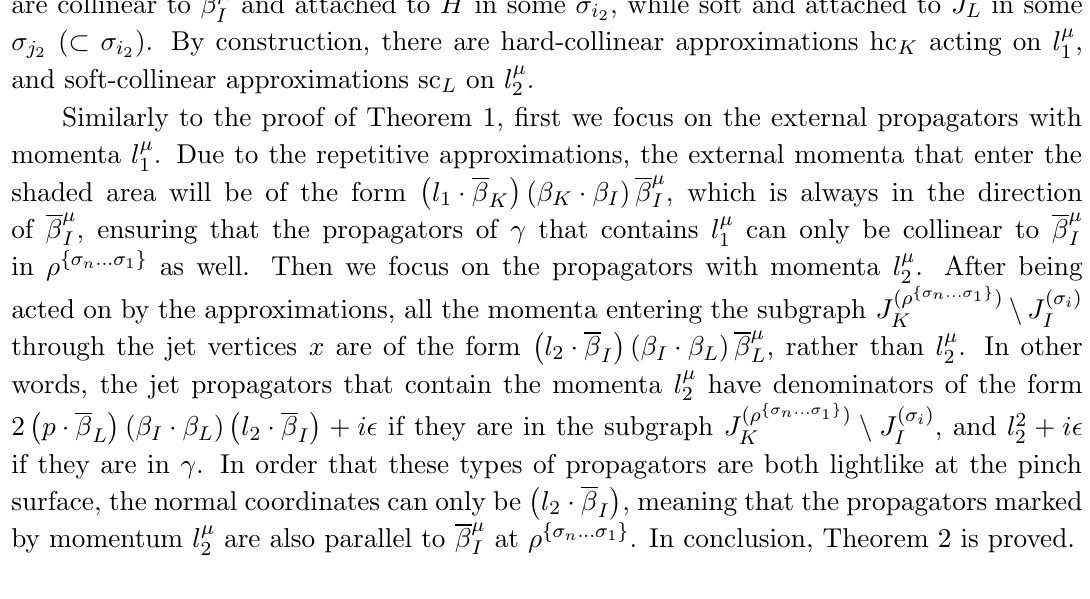
some (cid:27) , while soft and attached to J k 1